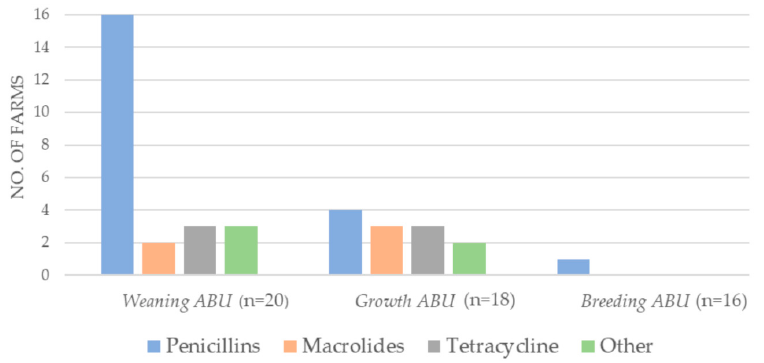
Figure 1. Antibiotic usage on mink farms (DK n = 20) during three short-term periods of the study period, 2018–2019. Number of mink farms with short-term consumption of the respective antibiotics (ABU), in the period just prior to the three sampling periods; weaning ABU (16 April–30 June), growth ABU (1 July–26 October), and breeding ABU (27 October 2018–25 March 2019). Other: Lincomycin in combination with spectinomycin; sulfamethoxazole in combination with trimethoprim, amphenicols, and aminoglycosides. On the included Danish farms, the overall consumption across the farms decreased and noticeably, by 50%, from 2017 to 2018 (2018: 1859.8 DADD/1000 biomass days; 2017: 3655.2 DADD/1000 biomass days) (DADD: defined daily animal dose, the assumed average dose needed to treat a 1 kg animal; biomass days calculated as in Jensen et al. [16]) (Supple ‐